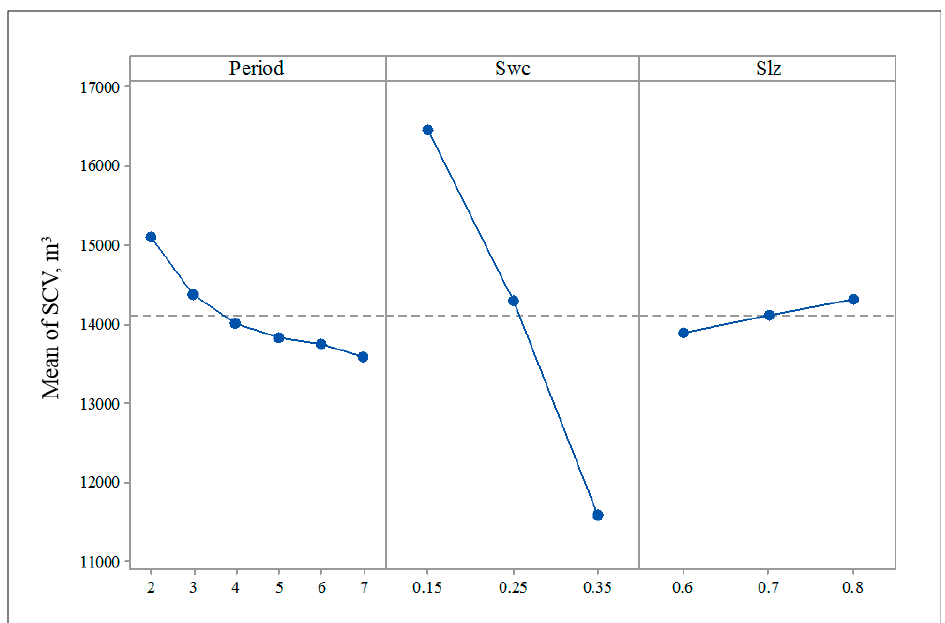
Figure 8. Main effect analysis for SCV.